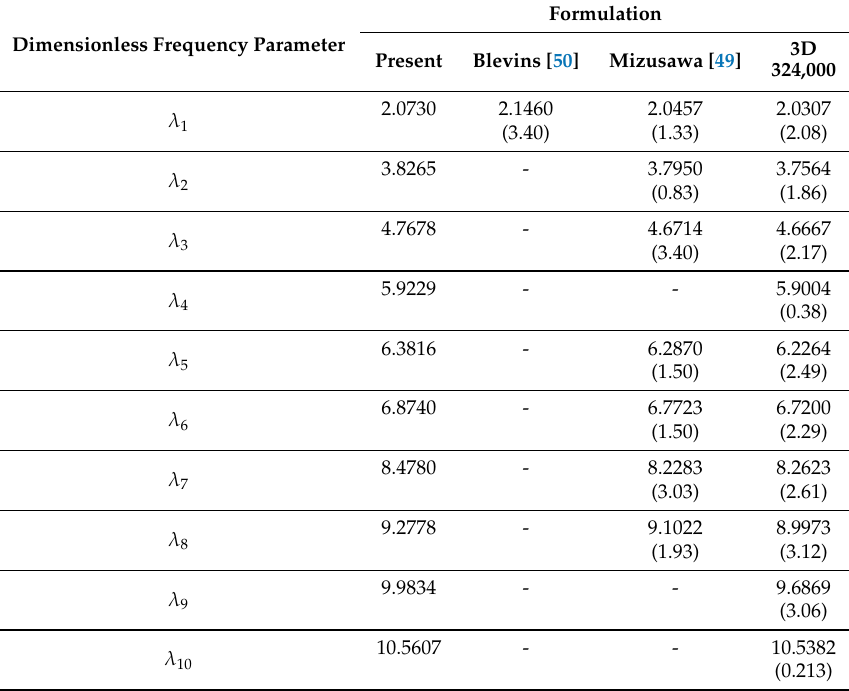
Table 10. Comparison of results for a square plate of ratio b / h 0 = 20 and SCSC boundary conditions.